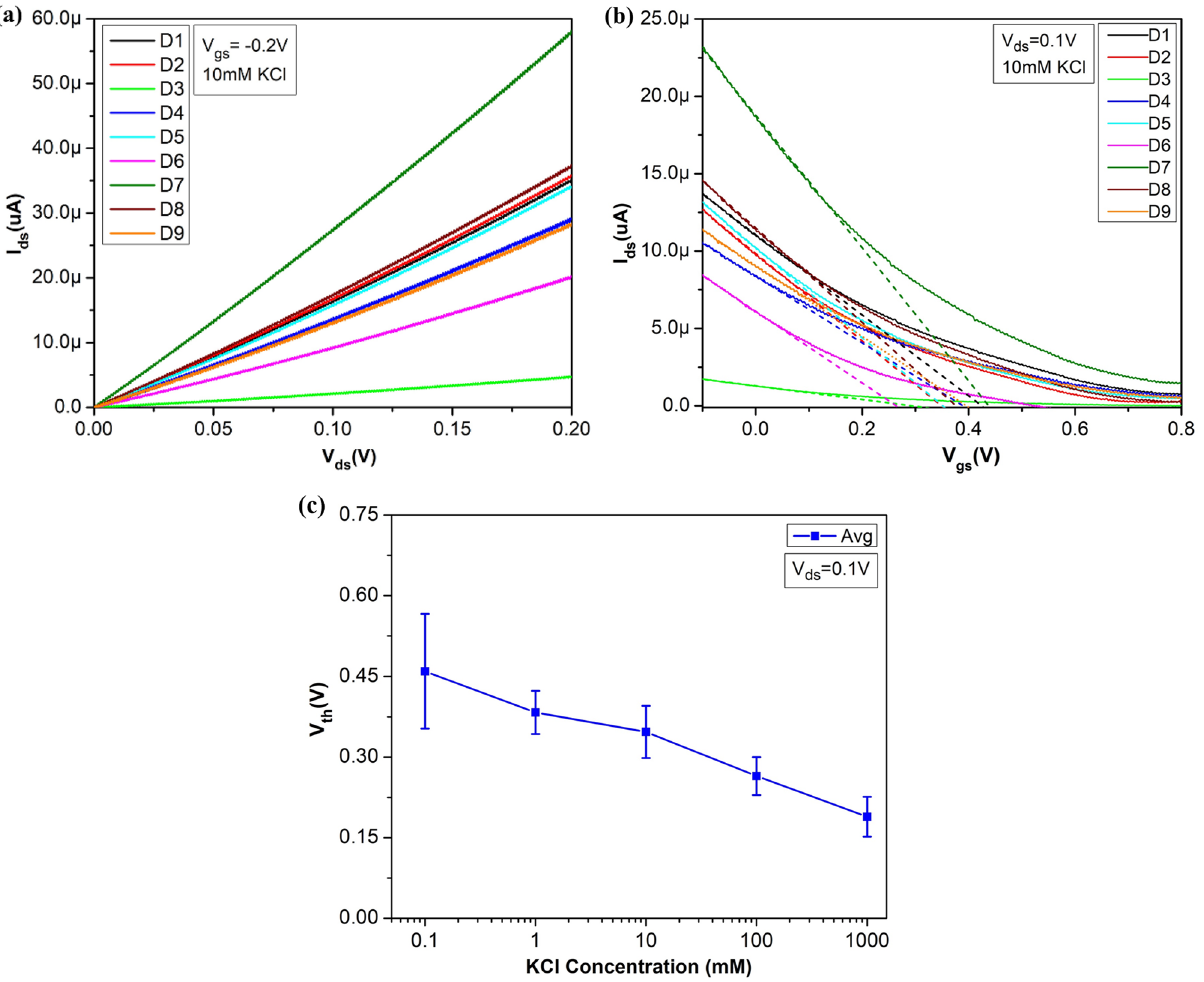
Figure 9. Electrical characteristics of 3 × 3 array of devices ( a ) Output characteristics for different devices at constant V gs ~ − 0.2 V for 10 mM KCl concentration ( b ) transfer characteristics for different devices at constant voltage V ds ~ 0.1 V and 10 mM KCl concentration, and similarity in V th for different devices for fixed 10 mM KCl concentration is shown by fitting (dashed line) the linear region of the corresponding transfer curve and (c) plot of an average value of V th for 9 devices of a chip for KCl concentrations along with error bar representation, while standard deviation as a source of error at each